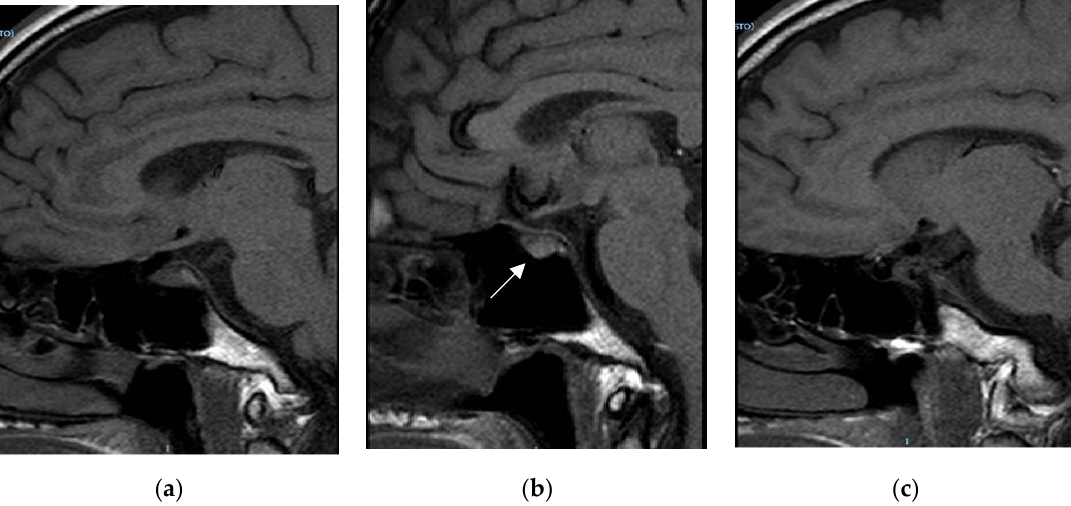
Figure 2. Follow-up MRI pituitary. Enhanced T1-weighted images showing disappearance of previously described pituitary lesion with normal stalk profile. ( a – c ) show sequential scan of the pituitary region previously interested by neoplasm.